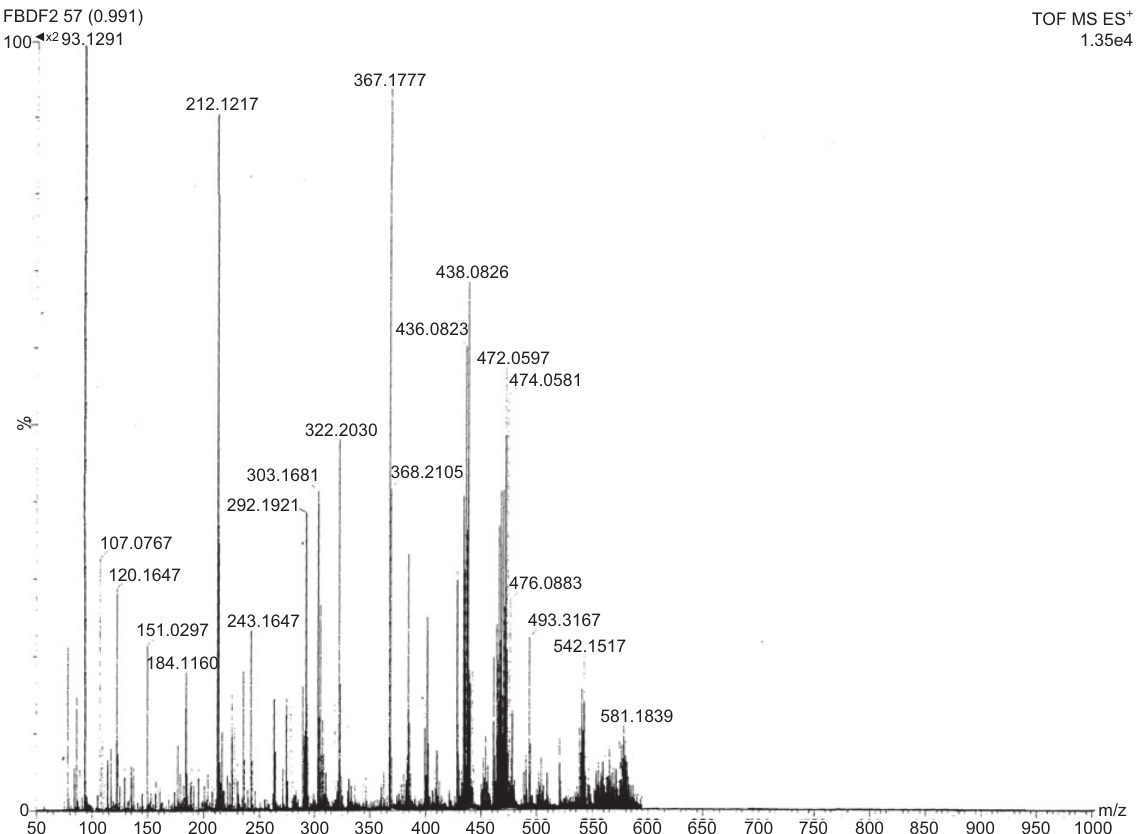
Figure 1 TOF-MS spectrum of [SnCl